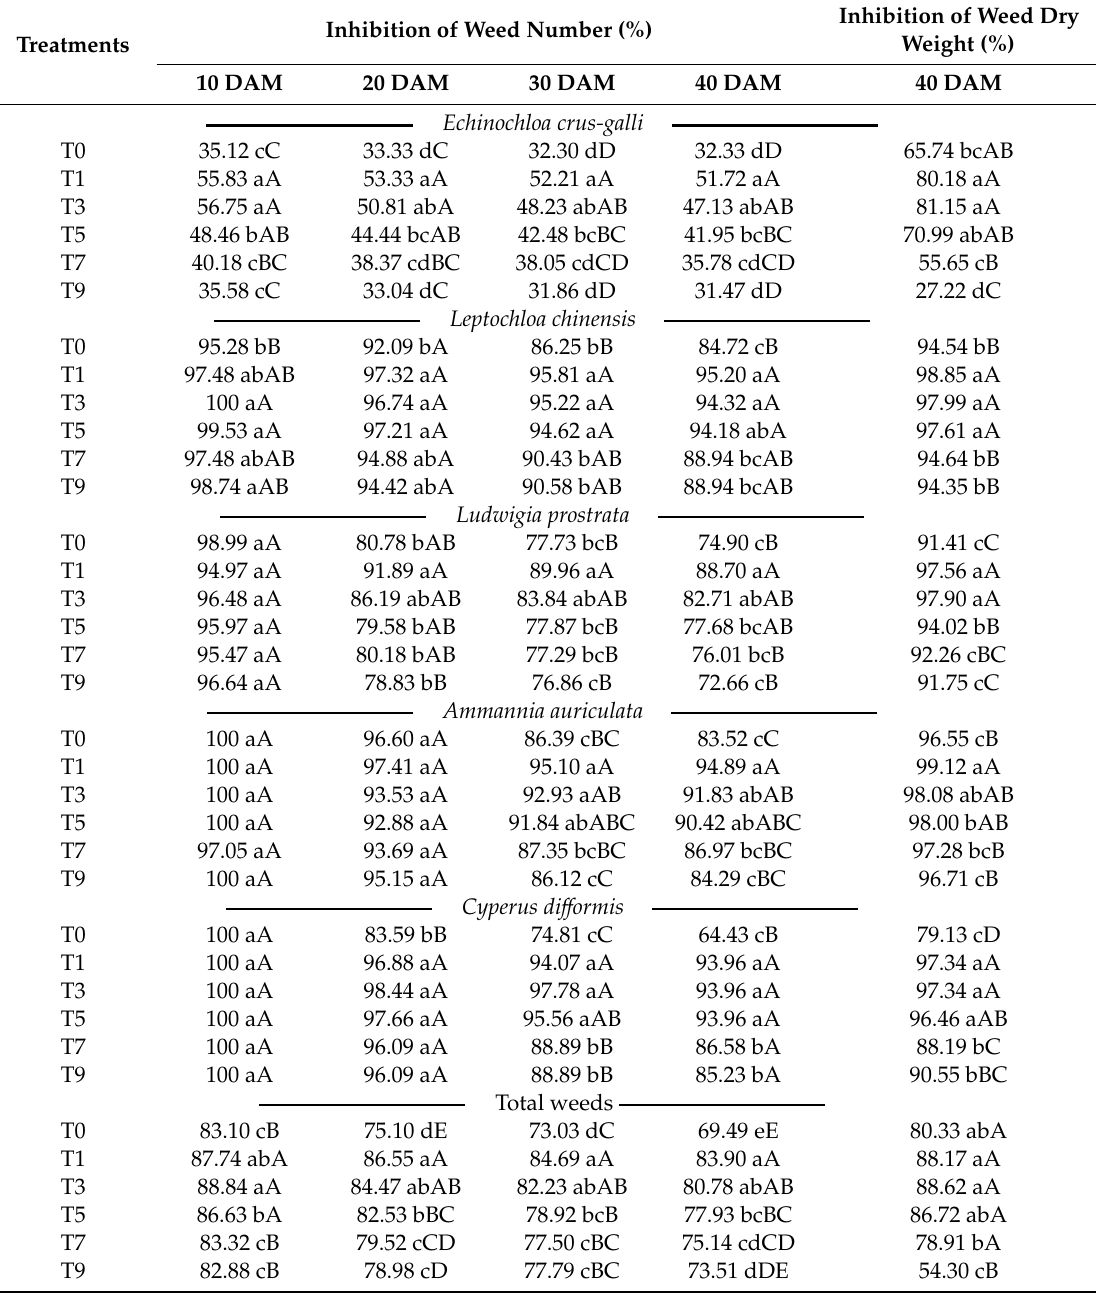
Table4. Inhibitorye ff ectsofoilseedrapestrawmulchonfivemajorweedsinsimulatedtransplantedrice.